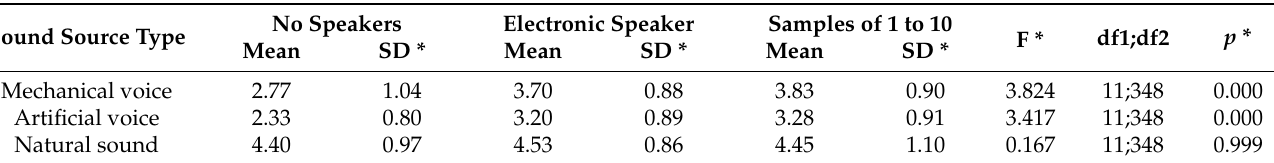
Table 9. Differences in sound source identification between no speakers, samples, and electronic speaker (popular